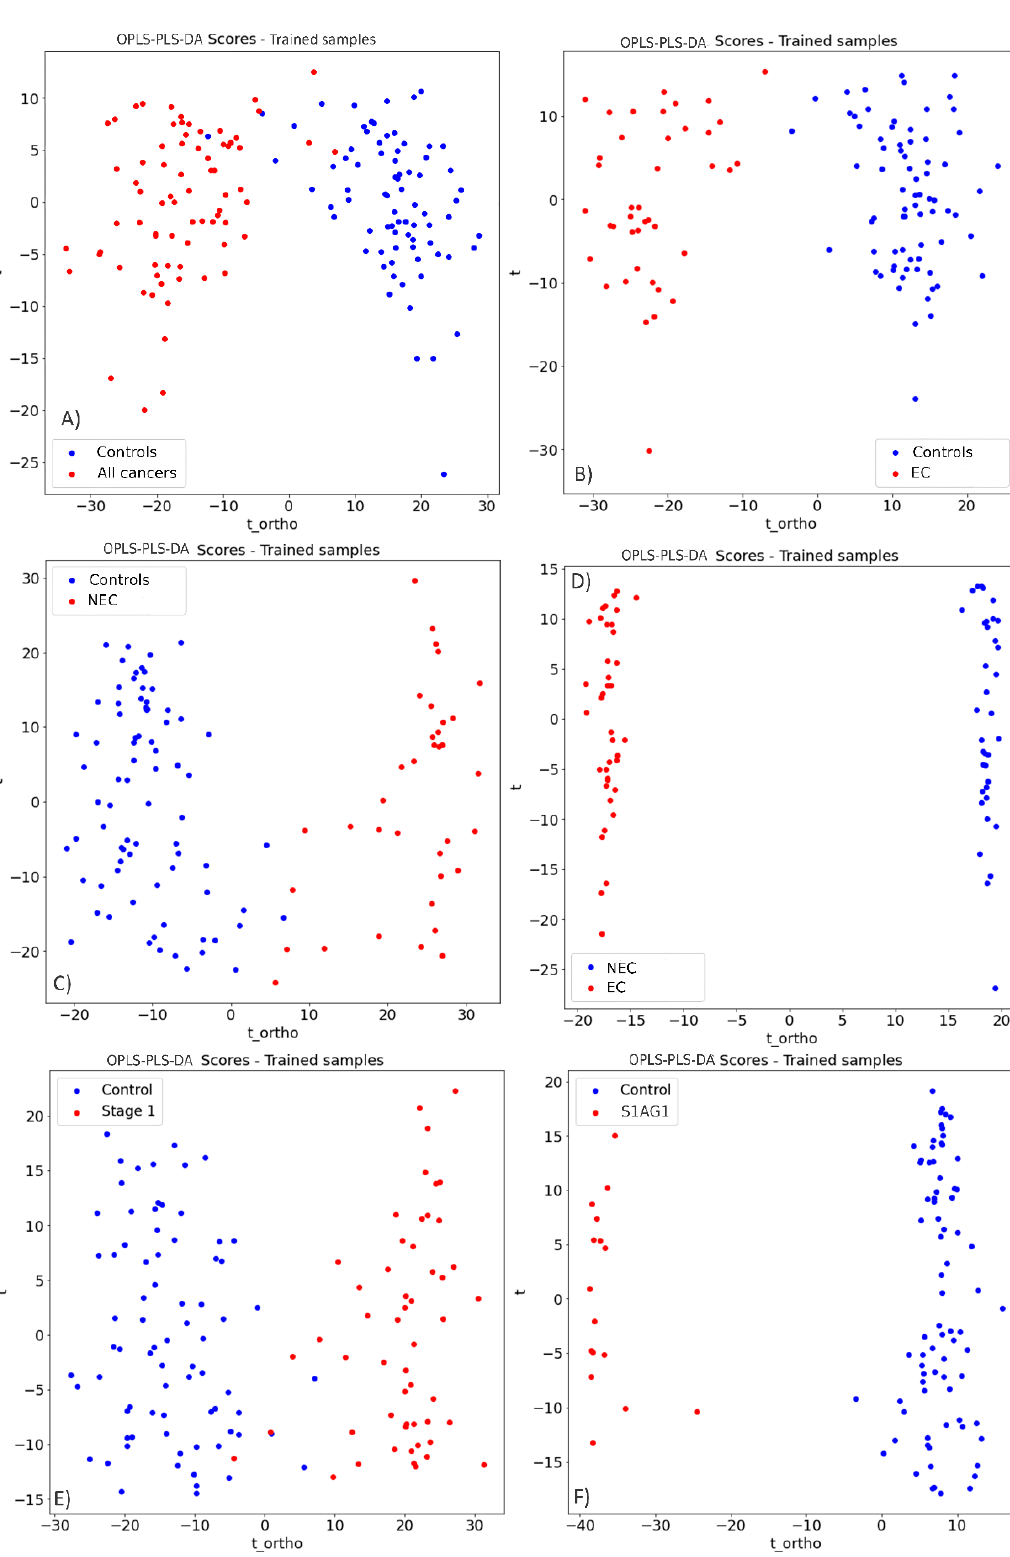
Figure 2. Discriminant analysis plots of all class comparisons. ( A ) Controls vs. all cancers. ( B ) Con- trols vs. endometrioid cancers (EC). ( C ) Controls vs. non-endometrioid cancers (NEC). ( D ) Endo- metrioid cancers vs. non-endometrioid cancers. ( E ) Controls vs. stage I cancers. ( F ) Controls vs. stage IA grade 1 cancers. After the application of PLS-DA it was possible to discern between classes, ob- taining a p < 0.0001 shows statistical significance on the discrimination analysis.